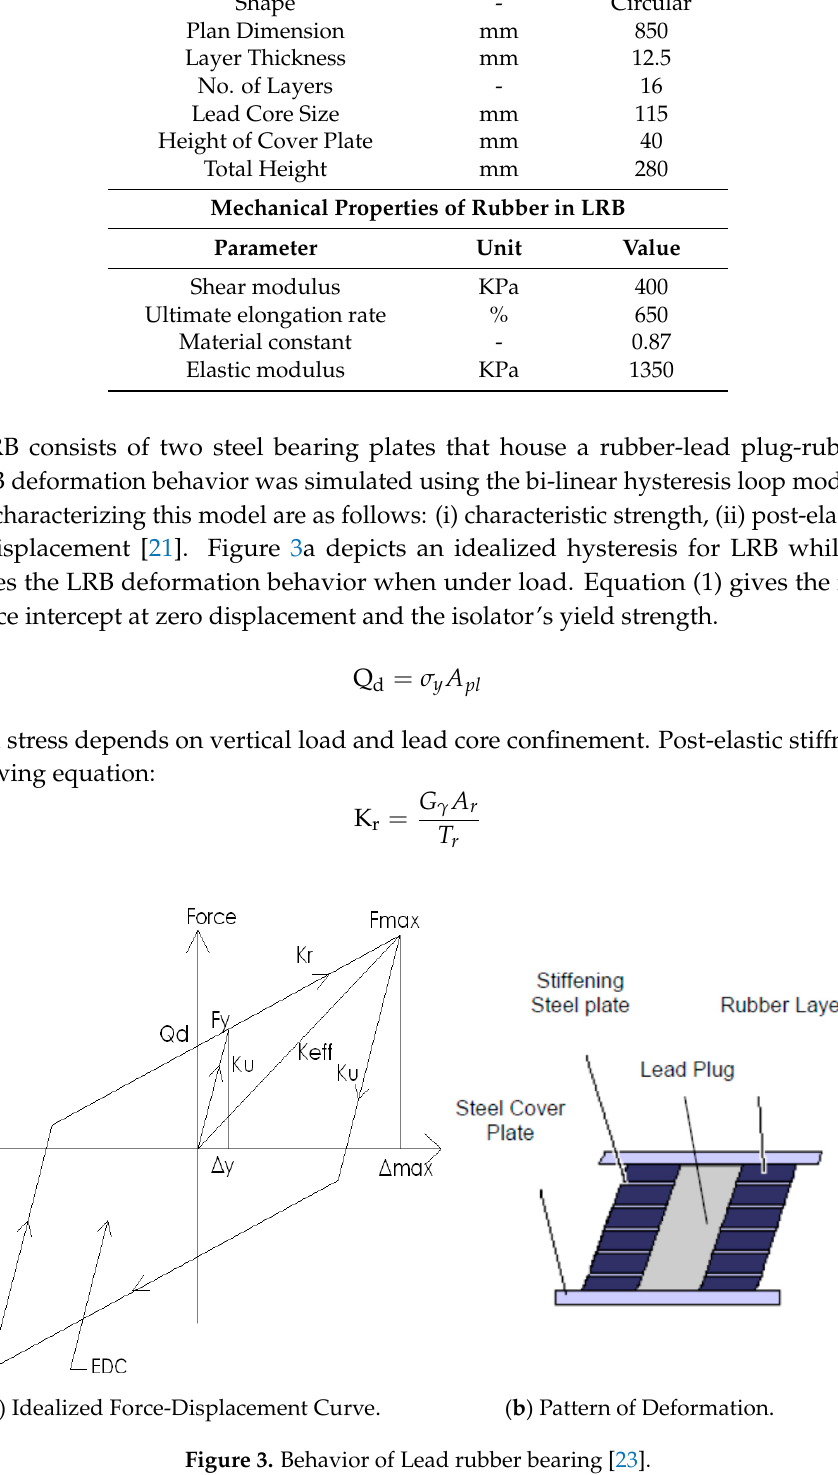
Figure 3. Behavior of Lead rubber bearing [23].